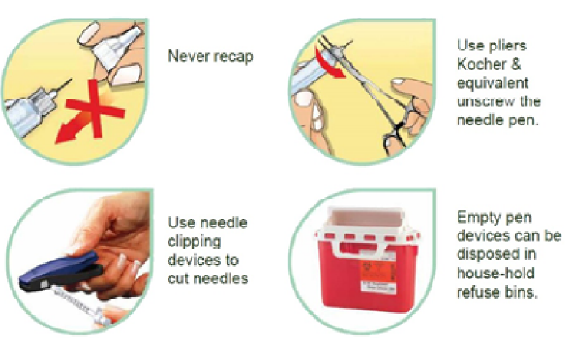
needle.Figure Figure 6. Needle reuse causes damage to the tip of the